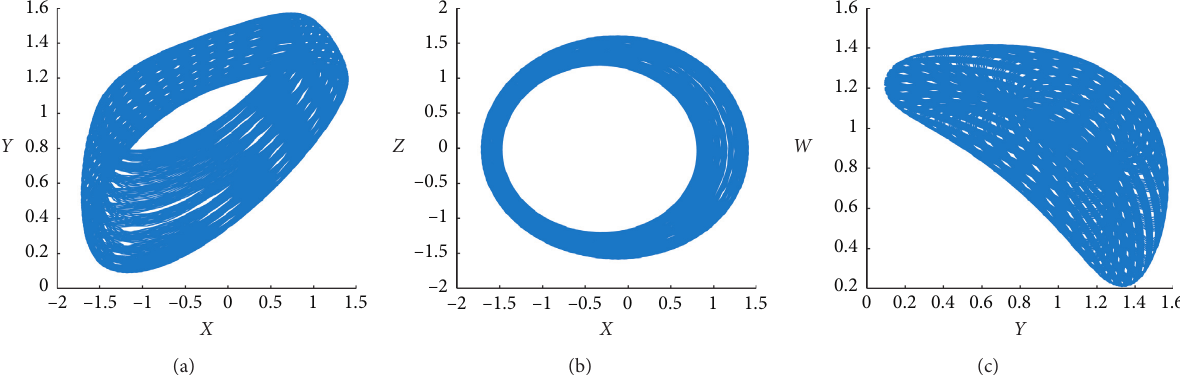
Figure 9: Phase portraits of Case 2 system on the different plane, with ( h,g,a, e ) � ( 0 . 5 , 10 , 6 , 5 . 5 ) and ( x plane. (b) x - z plane. (c) y-w plane.